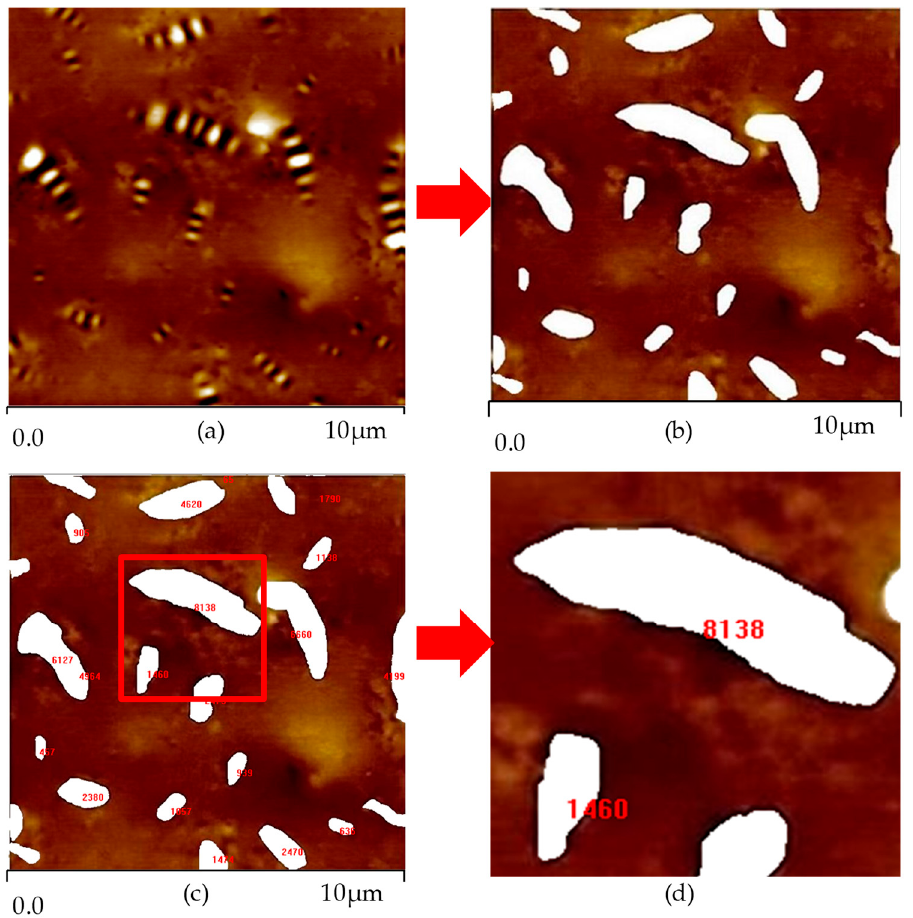
Figure 7. Bee-like structure area measurement. ( a ) two-dimensional bitumen atomic force microscope (AFM) image; ( b ) bee-like structure removal image; ( c ) calculation image of bee-like structure area; ( d ) partial enlargement image of calculation results of bee-like structure).